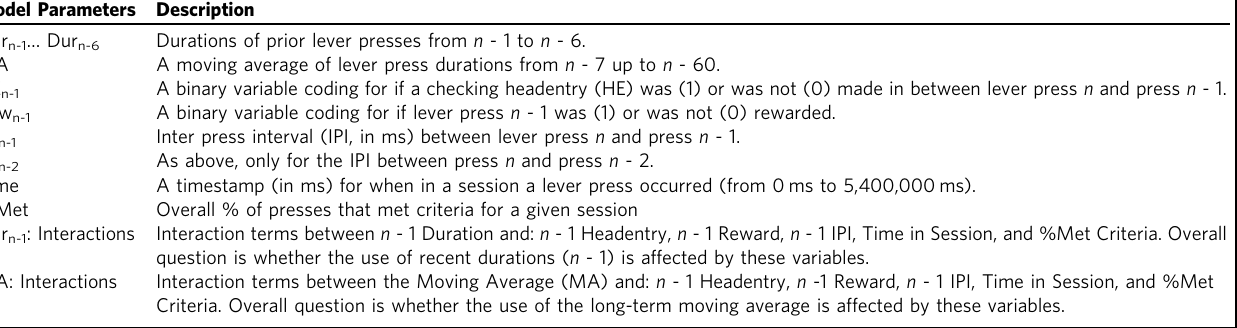
Table 1 Complex LME Model Parameters, related to Fig. 2. Model Parameters Description Dur n-1 … Dur